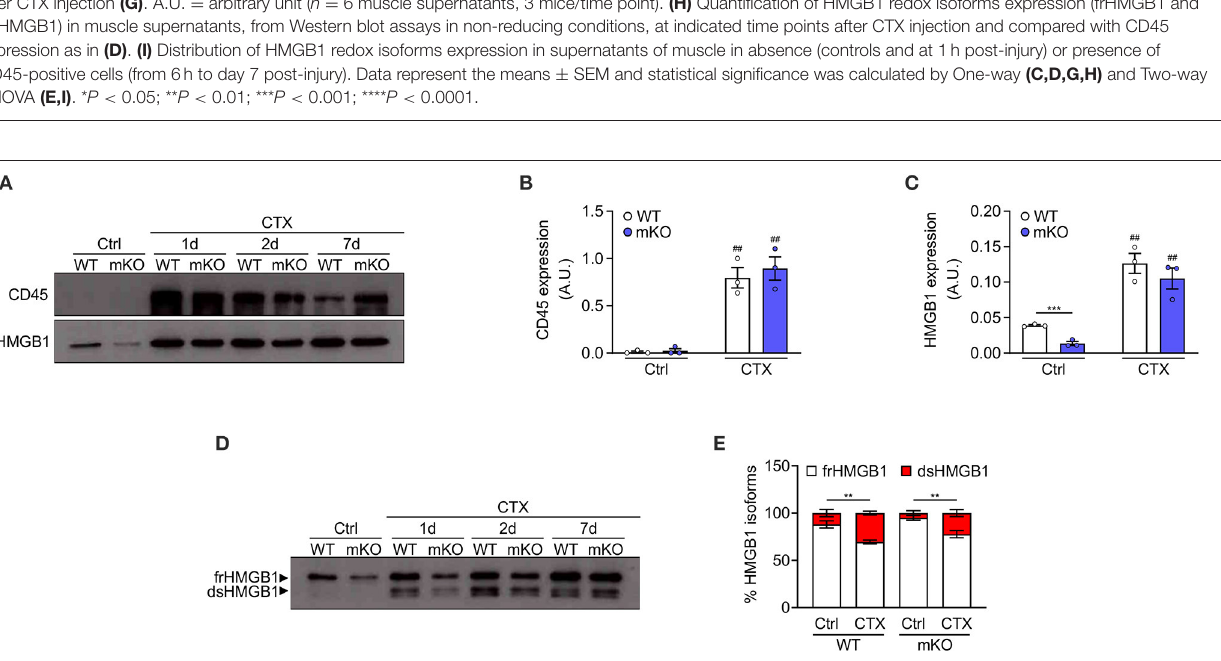
FIGURE 2 | Disulphide-HMGB1 derives from non-myogenic cells in injured muscle. (A) Western blot probed with anti-CD45 (upper panel) and anti-HMGB1 (lower panel) antibodies in reducing conditions on tibialis anterior (TA) muscle lysates from WT or HMGB1 mKO mice at indicated time points after cardiotoxin (CTX) injection. Ctrl, control uninjured muscles. (B,C) Quantification of CD45 (B) and HMGB1 (C) protein expression, normalized on Ponceau staining, before (Ctrl) and after CTX injection (CTX at 1, 2, and 7 d) in TA and triceps muscle lysates ( n ≥ 4 muscles/time point, n = 3 mice/genotype). A.U. = arbitrary unit. (D,E) Western blot probed with anti-HMGB1 antibody in non-reducing conditions (D) on TA muscle lysates from WT or HMGB1 mKO mice at indicated time points after CTX injection. The upper band corresponds to the fully reduced-HMGB1 (frHMGB1) and the lower band to the disulphide-HMGB1 (dsHMGB1). (E) Percentage of HMGB1 redox isoforms expression from WT or HMGB1 mKO mice before (Ctrl) and after CTX injection (CTX at 1, 2, 5, and 7 d) in TA and triceps muscle lysates ( n ≥ 3 muscles/time point; n ≥ 4 mice/genotype). Data represent the means ± SEM and statistical significance was calculated by Student T -test (B,C) and Two-way ANOVA (E) . ** P < 0.01; *** P < 0.001; ## P < 0.01 (Ctrl vs.